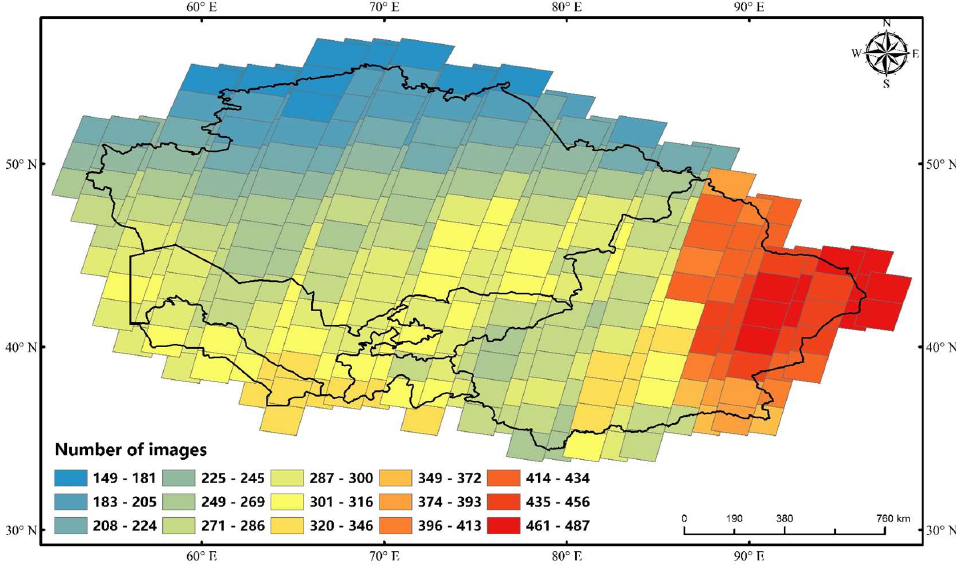
Figure 2. Coverage of the number of Landsat 5 TM, Landsat 7 ETM + , and Landsat 8 OLI images from 2000 to 2015.